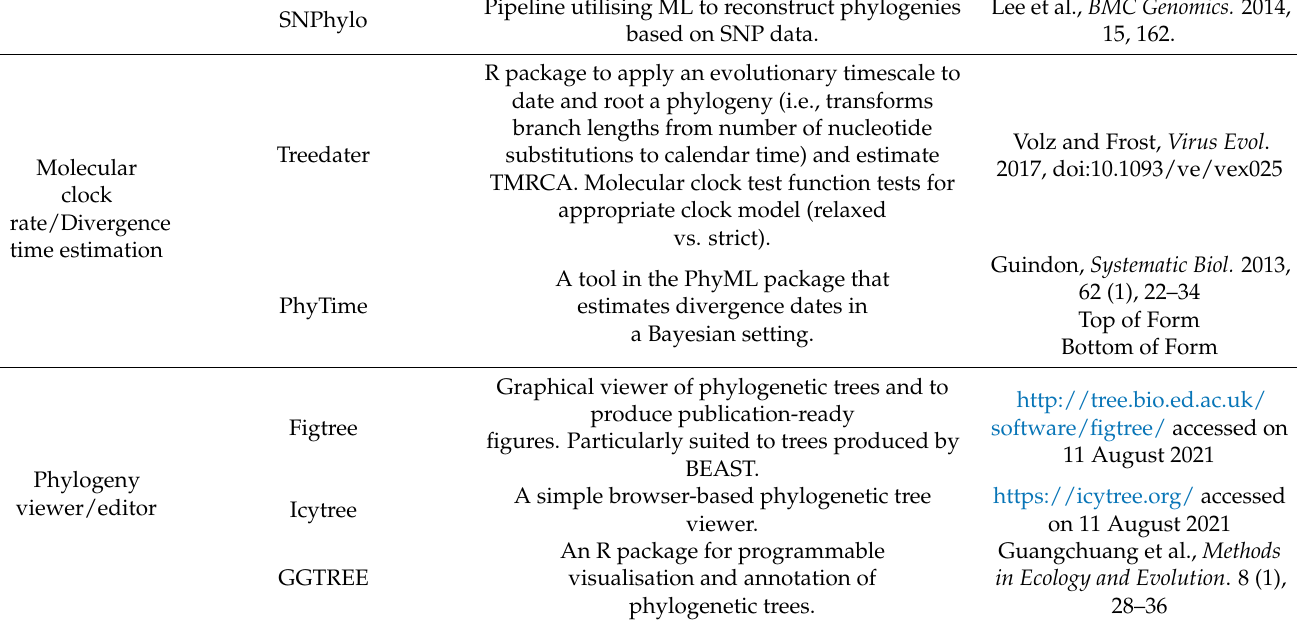
Graphical viewer of phylogenetic trees and